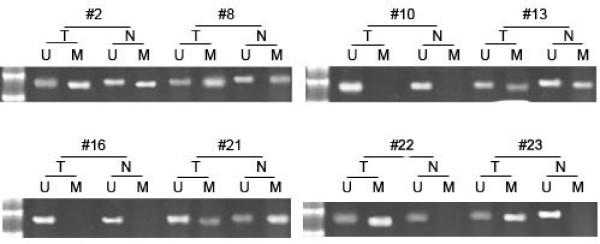
Analysis of SFRP5 methylation in primary gastric cancer specimens (T) and matched normal tissue specimens (N) by Methylation-specific PCR. Shown are representive results from specimen #2, #8, #10, #13, #16, #21, #24 and #29. M: methylated primers; U: unmethylated primers.